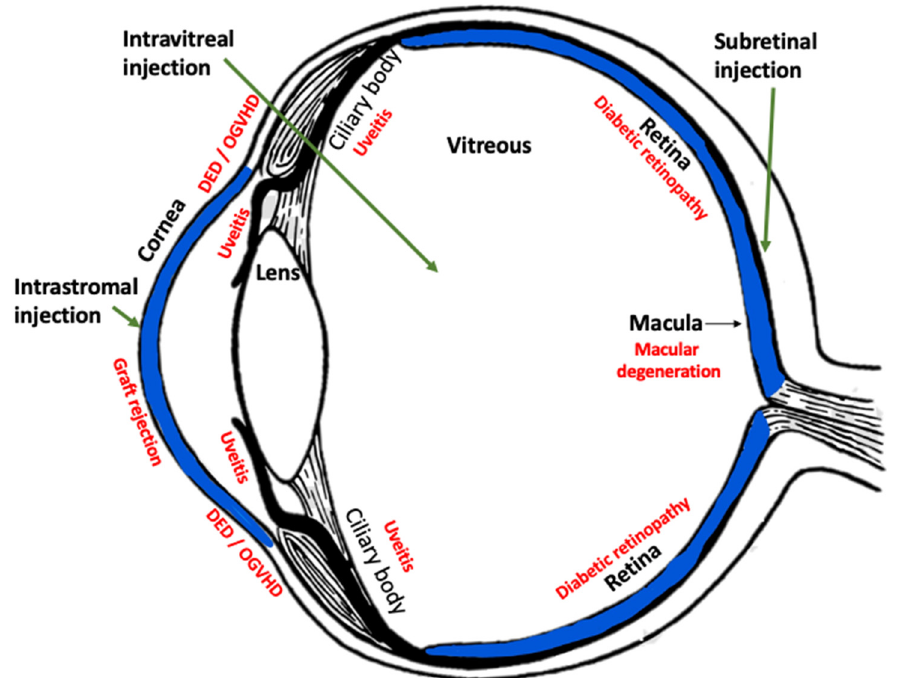
Figure 2. Diagram of human eye demonstrating anatomic structures and sites of injection for AAV gene therapy (green arrows). Blue highlighted areas are where HLA-G has been detected in the normal eye. Red letters indicated common diseases likely to be treated by AAV-HLA-G. DED = dry eye disease; OGVHD = ocular graft vs. host disease (modified from pinpng.com; Accessed on 8 February 2022).